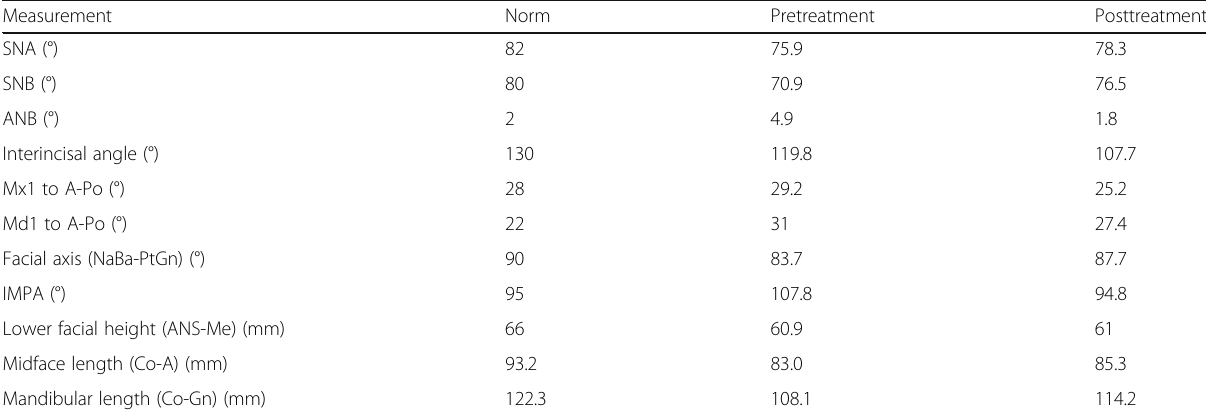
Table 1 Cephalometric measurements of patient 1